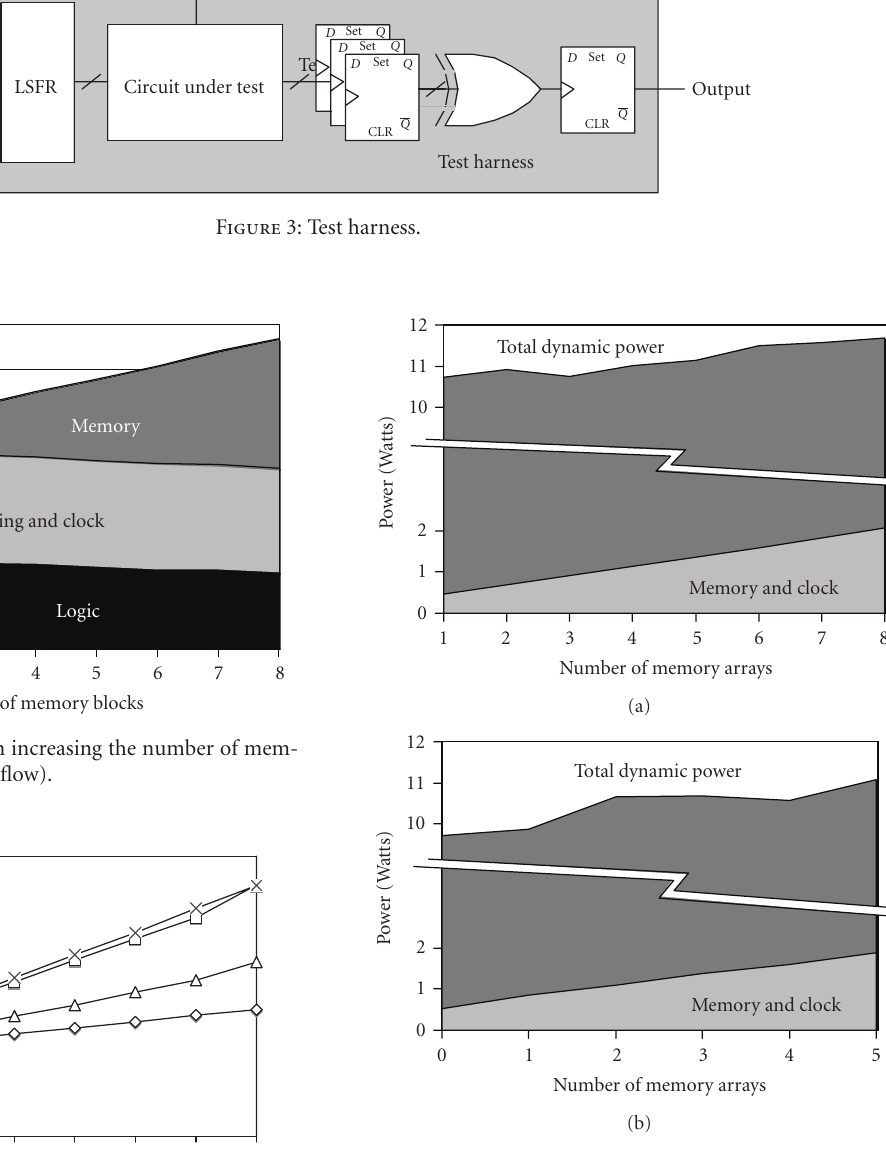
Figure 6: Impact on power when increasing the number of memory arrays (measured flow): (a) 512-bit arrays, (b) 4096-bit